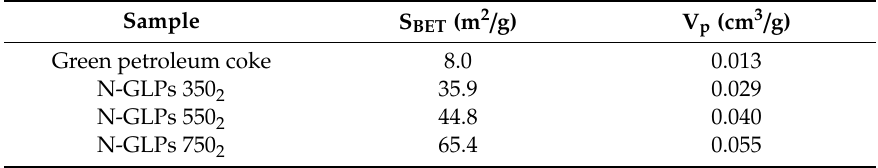
Table 1. Surface area and porous volume of the green petroleum coke and N-doped samples. Sample